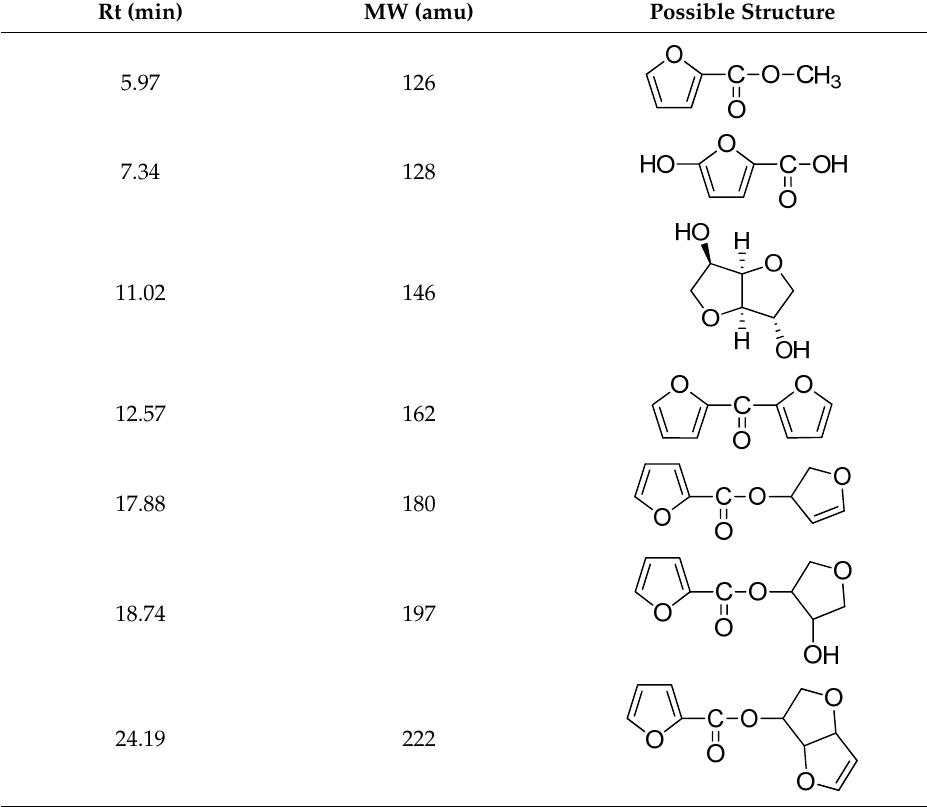
Table 4. Identified pyrolysis products of PIsF.